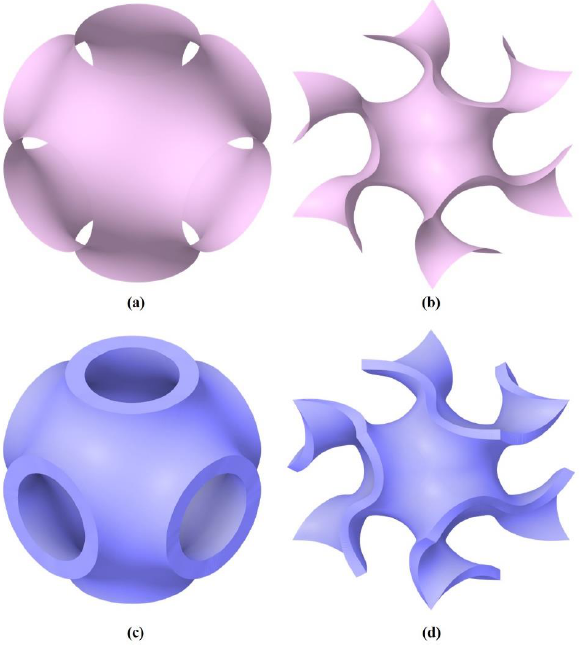
Figure 1. Illustrations of open and closed implicit TPMS unit cells: ( a ) Open Primitive (P) surface, ( b ) Open Gyroid (G) surface, ( c ) Closed Primitive (P) surface, ( d ) Closed Gyroid (G) surface.